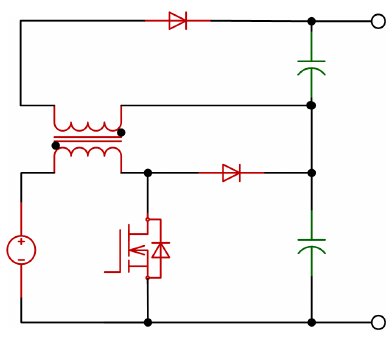
Figure 7. The circuit topology of flyback DC/DC